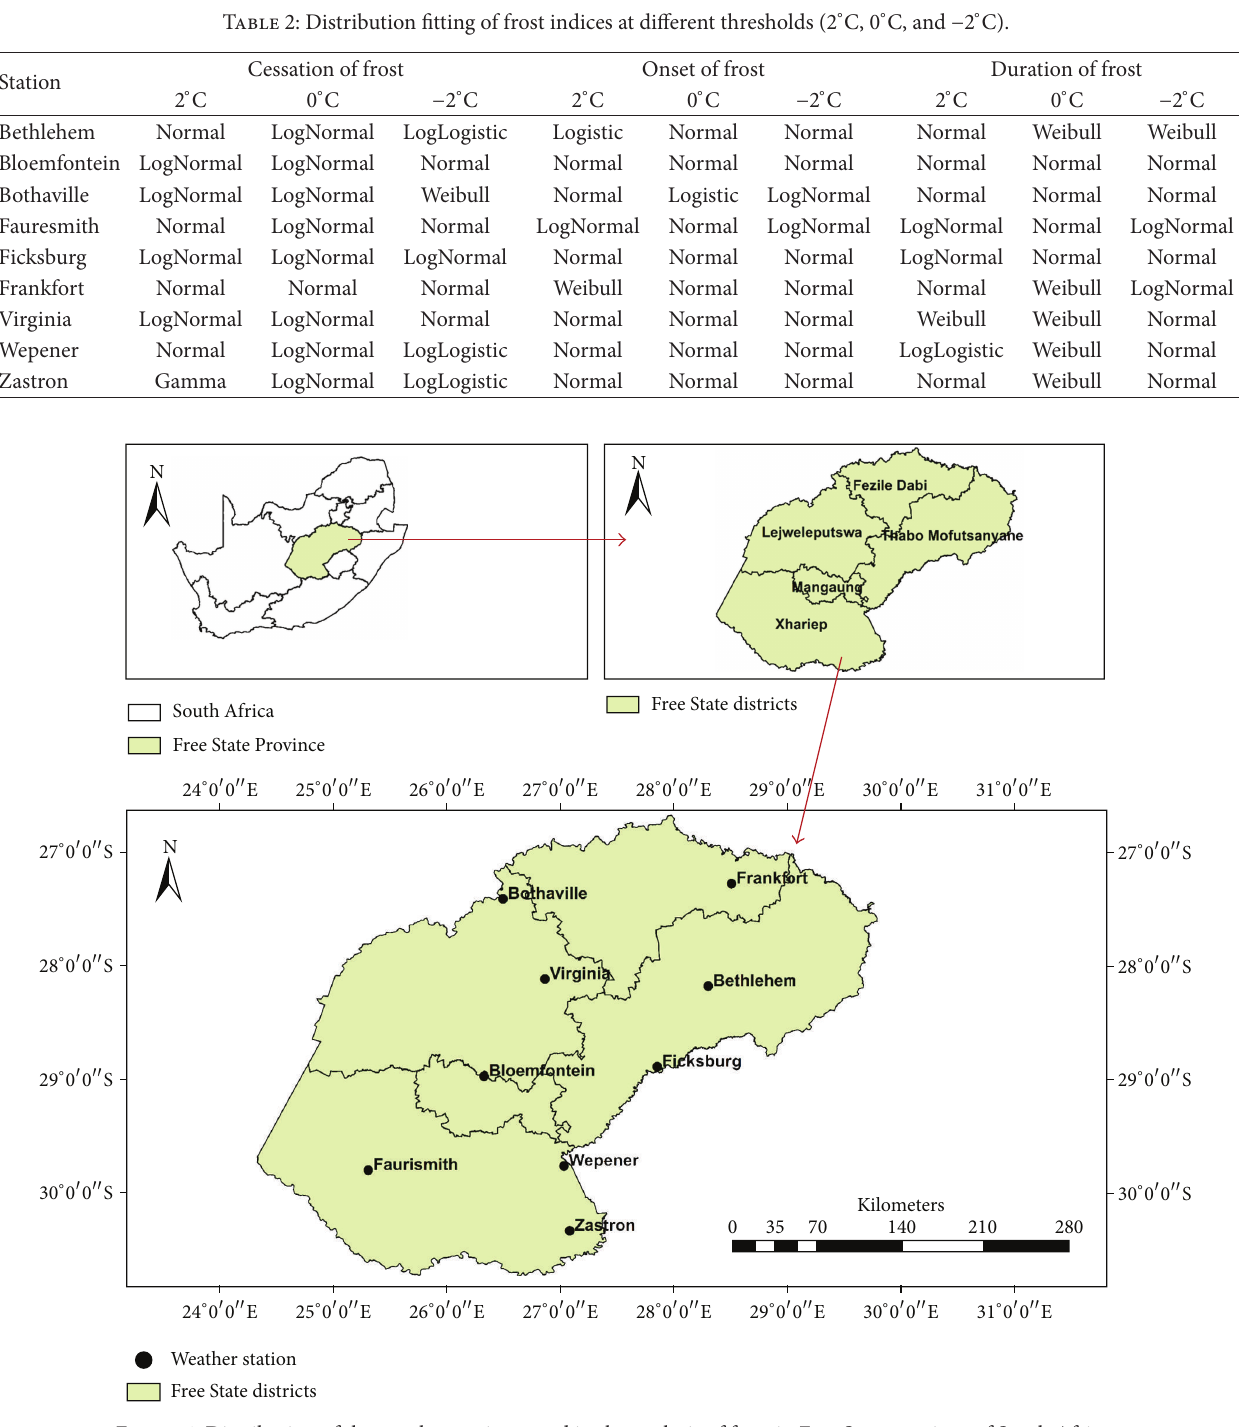
Figure 1: Distribution of the weather stations used in the analysis of frost in Free State province of South